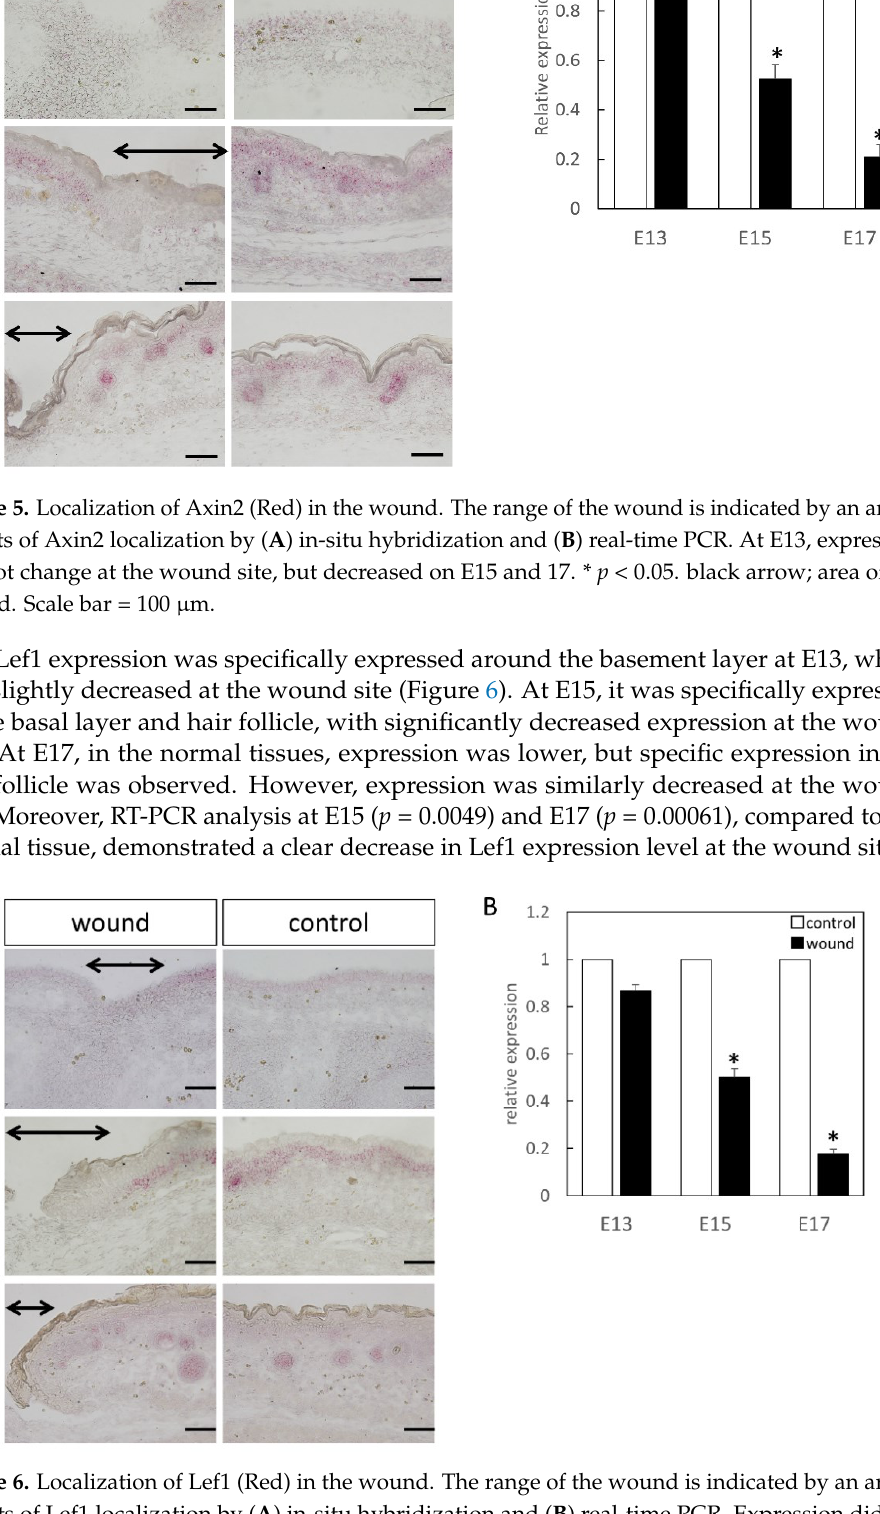
Figure 4. Localiz ation of β -catenin by immunohistochemistry. The range of the wound is indicated by a yellow arrow. Brown: β -catenin. Purple: Hematoxylin. Black arrow: Area of the wound. Scale bar = 100 μm.